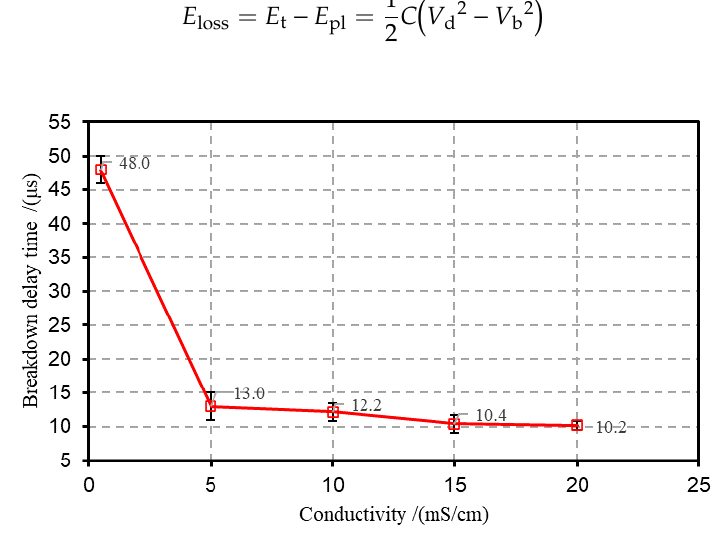
Figure 7. Breakdown delay time under different electrical conductivity.